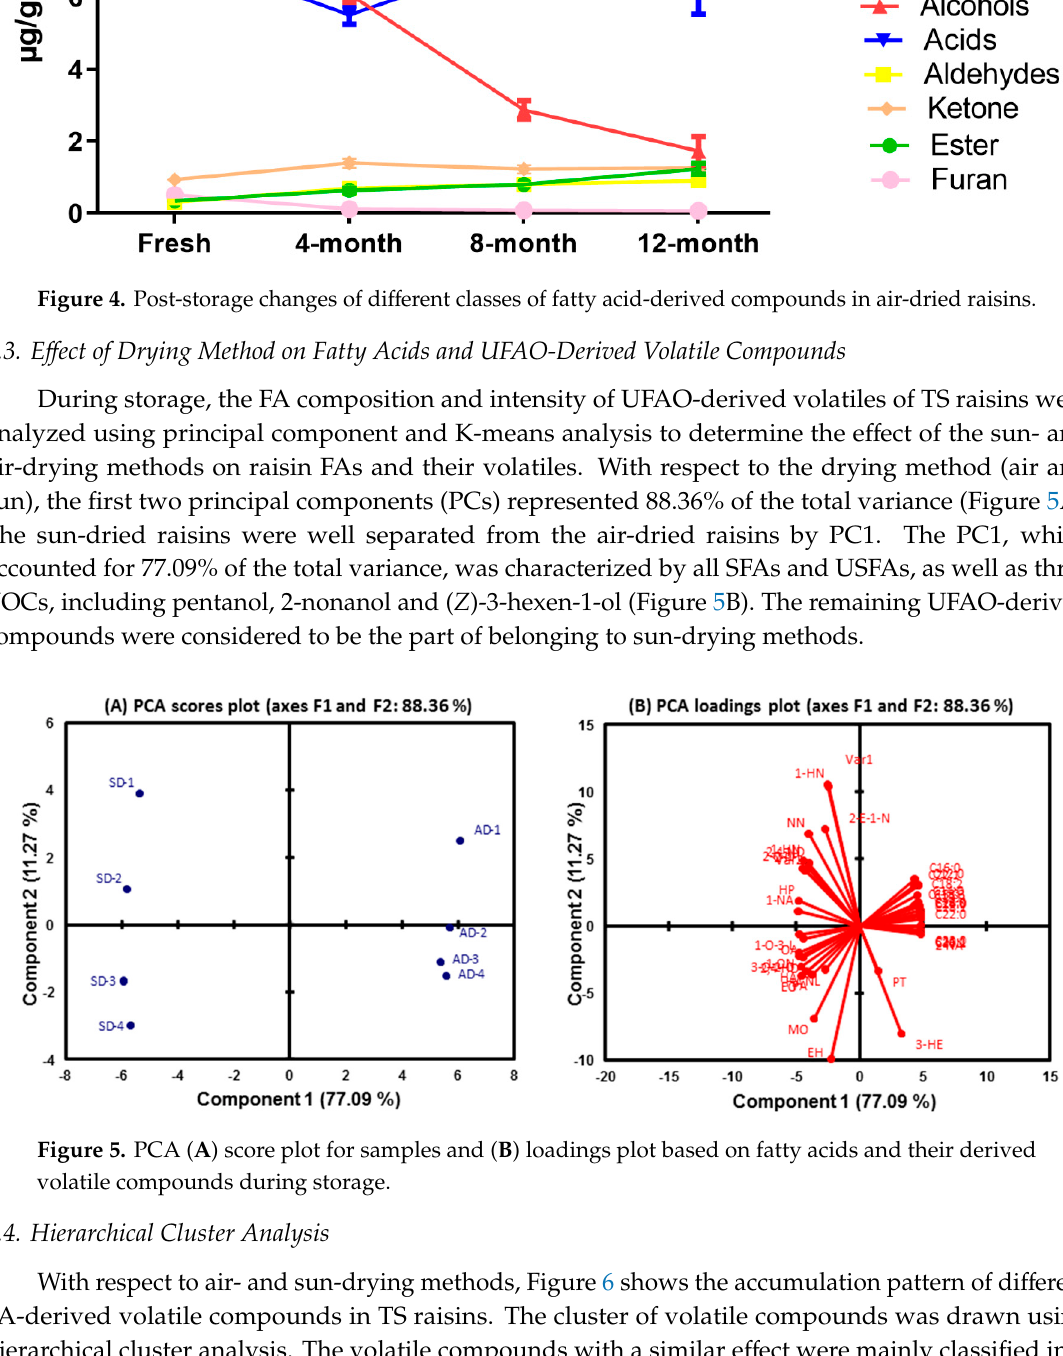
Figure 3. Post-storage changes of different classes of fatty acid-derived compounds in sun-dried raisins.